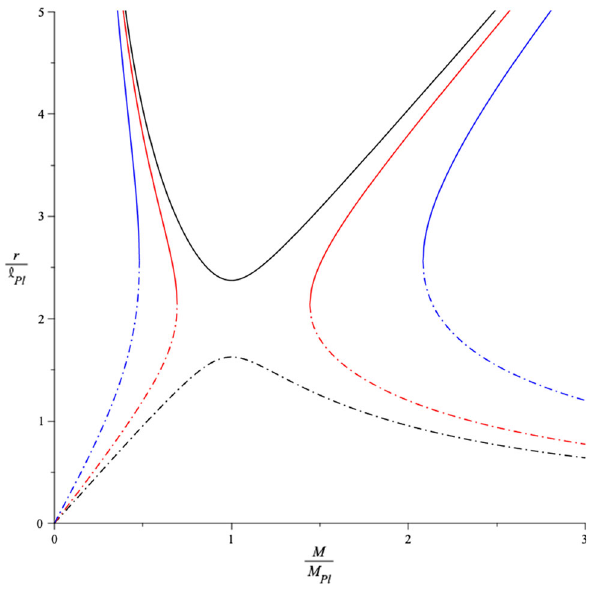
Fig. 6 Outer (solid) and inner (dash-dot) horizon size for GUP-RN black hole with β = 2, showing the pre- ( n = 23, black) and post- ( n = 25,blue,and n = 30,red)phasetransitionbehaviour.Thehorizons for n > 23 reach their maximum (left) or minimum (right) size at M 1 and M 2 , respectively. There are no black holes in the mass-gap between these values